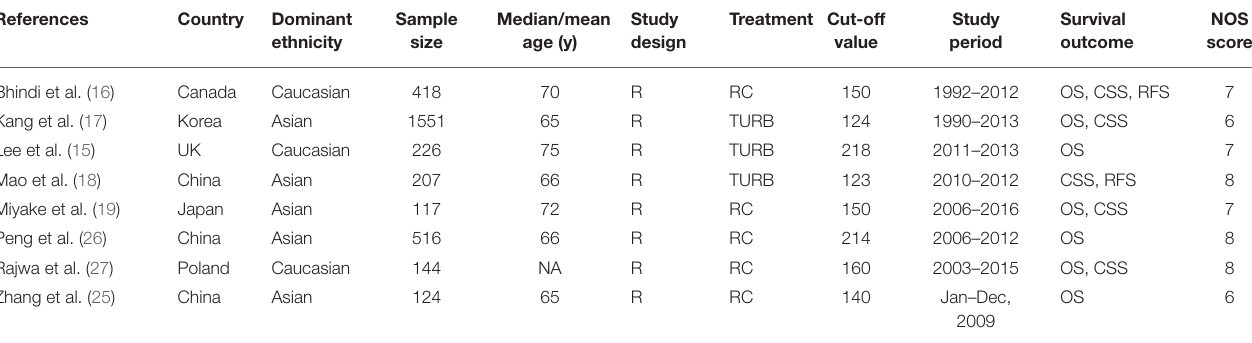
TABLE 1 | Baseline characteristics of studies included in the